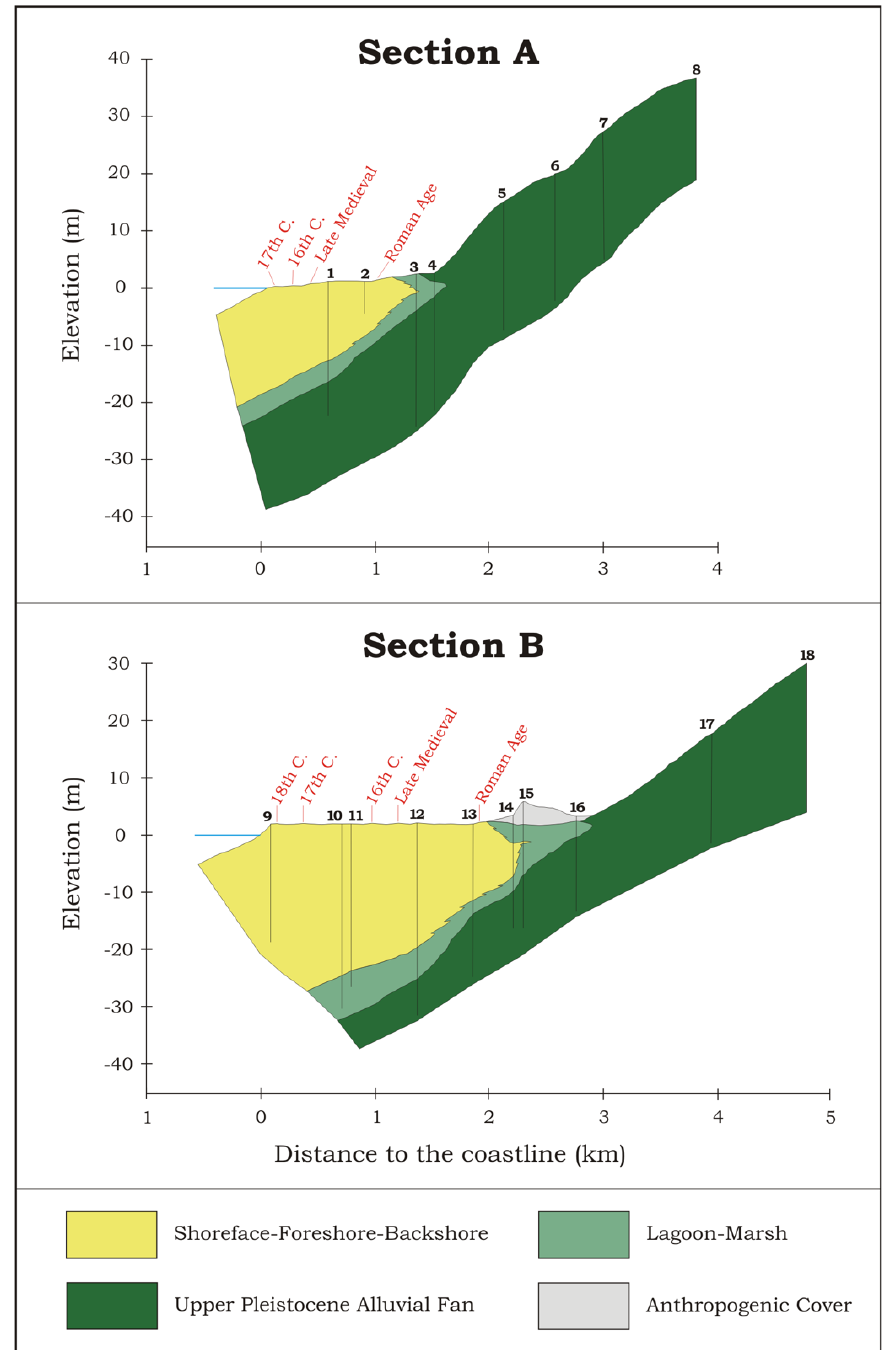
Figure 4. Stratigraphic sections A and B. The current position of the coastline is located at 0 m along the x-axis. The numbers in black correspond to the boreholes used to produce the sections. The vertical scale is exaggerated by a factor of 20. 1: SIRA 54; 2: SIRA 55; 3: DAPAT 125; 4: DM 85; 5: DC OLIV EMW 3a; 6: DC OLIV EMW 7; 7: DC PRAN S12 secondo; 8: DC PRAN S282; 9: SIRA 136; 10: SIRA 145; 11: DC PRAN S96; 12: DAPAT 112; 13: DM 108; 14: DC PRAN S122; 15: SIRA 170; 16: DPS S2; 17: DAPAT 198; 18: DAPAT 229.